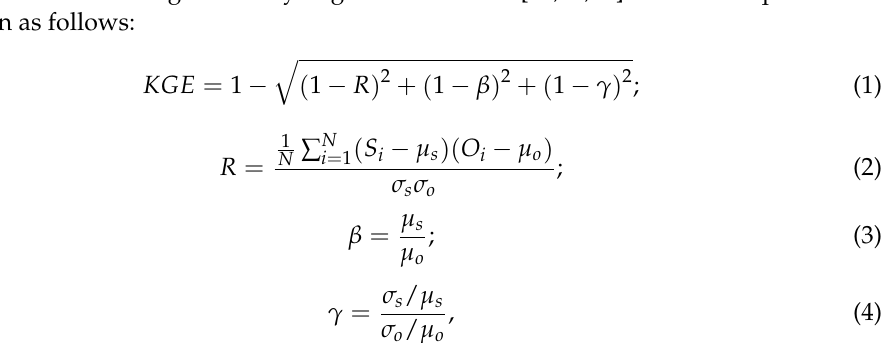
Table 1. List of the selected 13 extreme indices from ETCCDI used in this study.